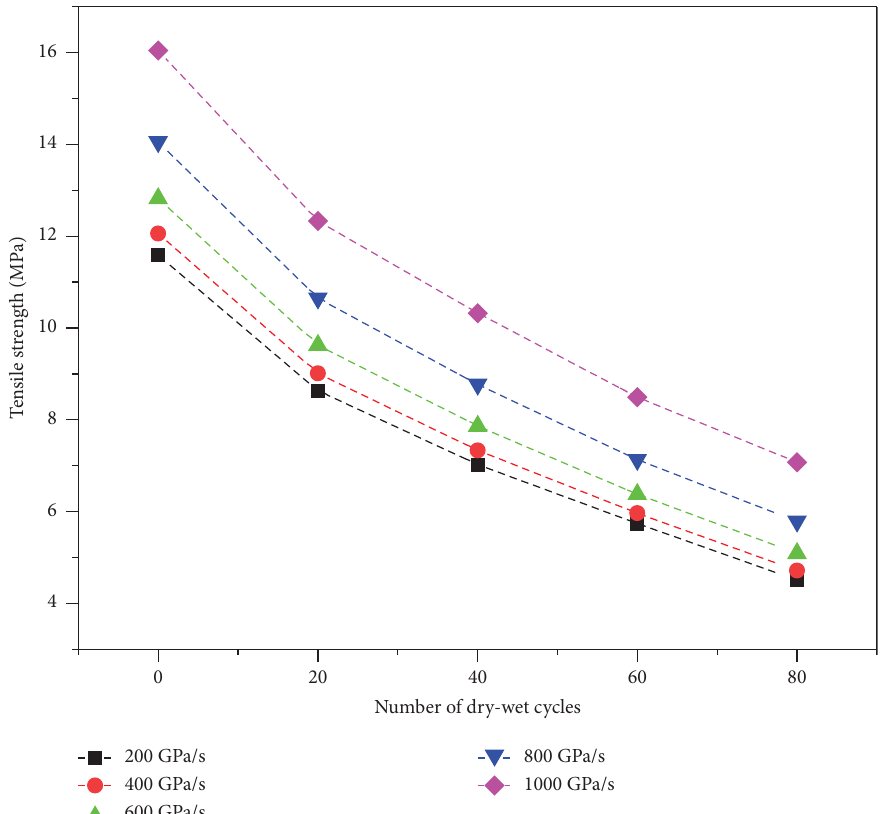
Figure 8: Change law of σ t of red sandstone samples versus n